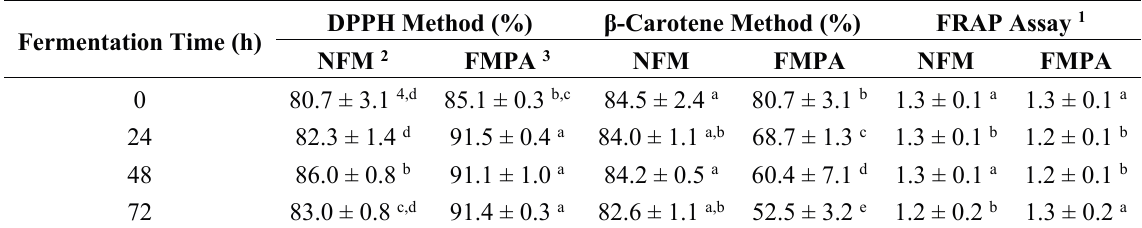
Table 2. Antioxidative activities of M. denudata extract fermented by P. acidilactici KCCM 11614 as determined by the DPPH, β -carotene, and FRAP